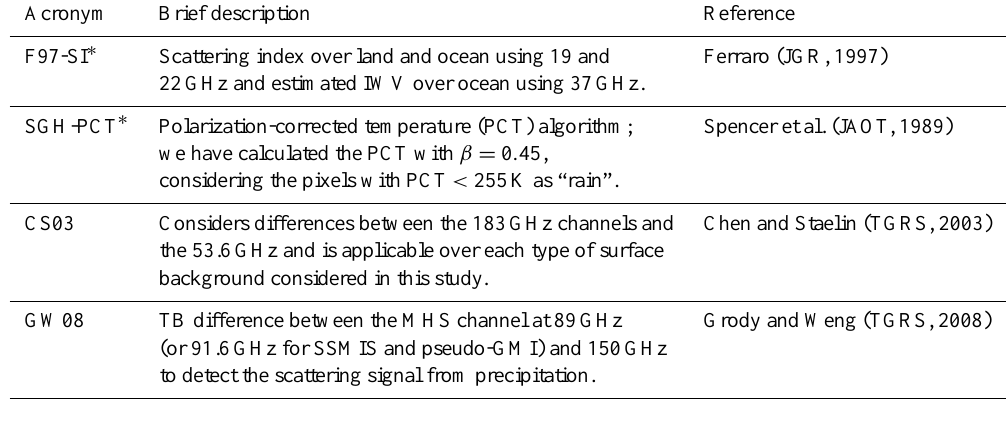
Table 2. Algorithms used for comparison in the study. ∗ Used only for SSMIS and pseudo-GMI data sets.